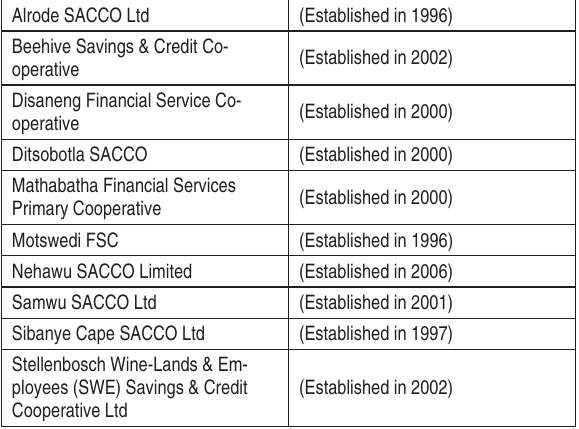
Table 1. Financial service cooperatives banks in South